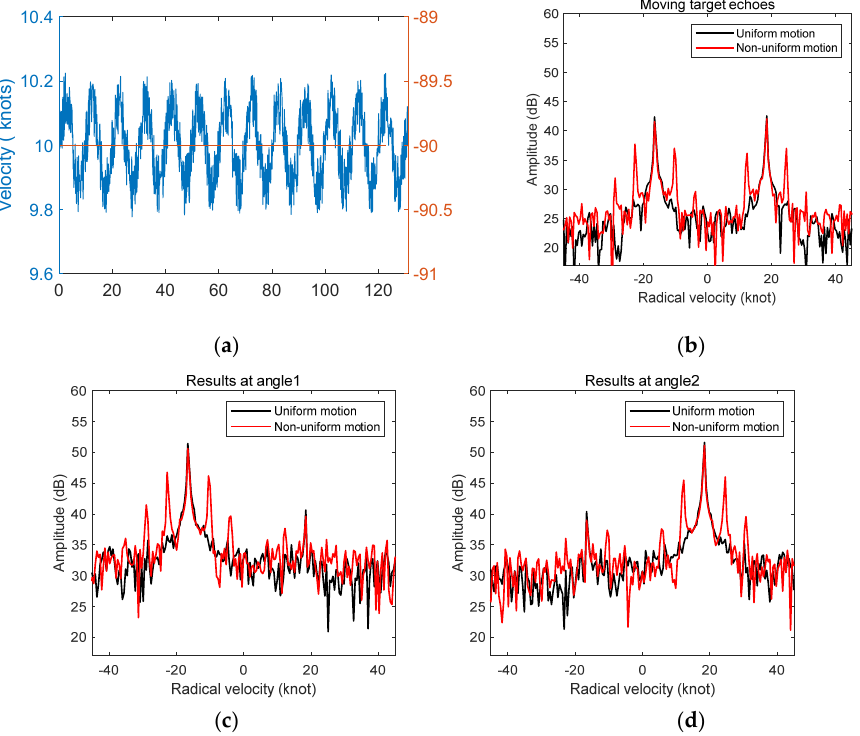
Figure 7. Simulation results of target echo when the velocity of the platform varies periodically: ( a ) the distribution of the velocity and heading of the platform , ( b ) channel results , ( c ) beam result at range1, ( d ) beam result at range2.